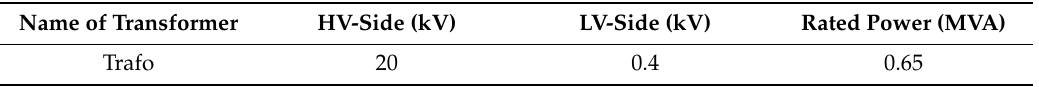
Table A2. Characteristics of the secondary substation.